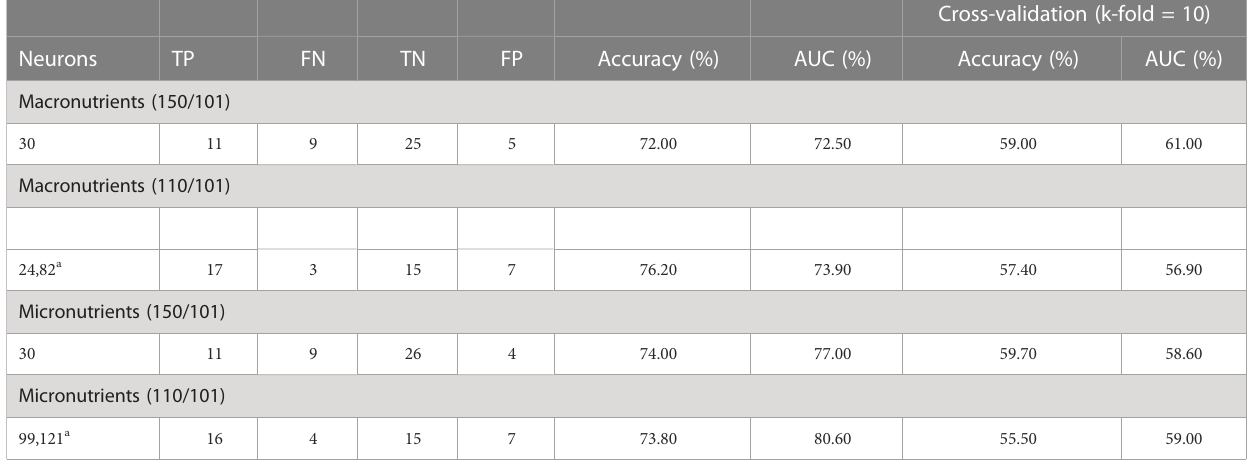
Cross-validation (k-fold =